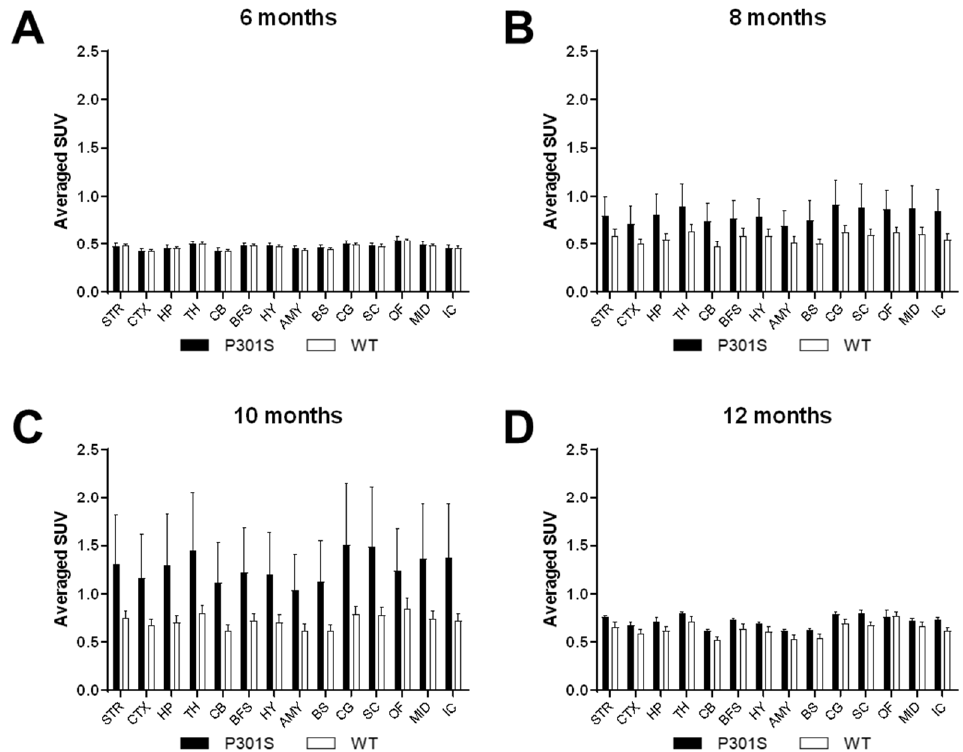
Figure 2. Quantitative analysis of PET imaging. Images were fitted to specific regions of interest (ROIs), and radioligand binding was assessed using averaged standard uptake value (SUV). Quantification was performed in different brain regions in P301S (black bars) and WT (white bars) mice, being plotted and analyzed at 6 ( A ), 8 ( B ), 10 ( C ), and 12 ( D ) months of age. Two-way ANOVA estimated no significant differences at 6 months ( p > 0.05), whereas analysis of overall brain imaging obtained at 8, 10, and 12 months indicated statistically significant increases ( p < 0.001, p < 0.0001, and p < 0.0001, respectively) between P301S and WT mice. STR: striatum, CTX: cortex, HP: hippocampus, TH: thalamus, CB: cerebellum, BFS: basal forebrain and septum, HY: hypothalamus, AMY; amygdala, BS: brain stem, CG; cingulate gyrus, SC: superior colliculi, OF: olfactory bulb, MID: midbrain, IC: inferior colliculi.